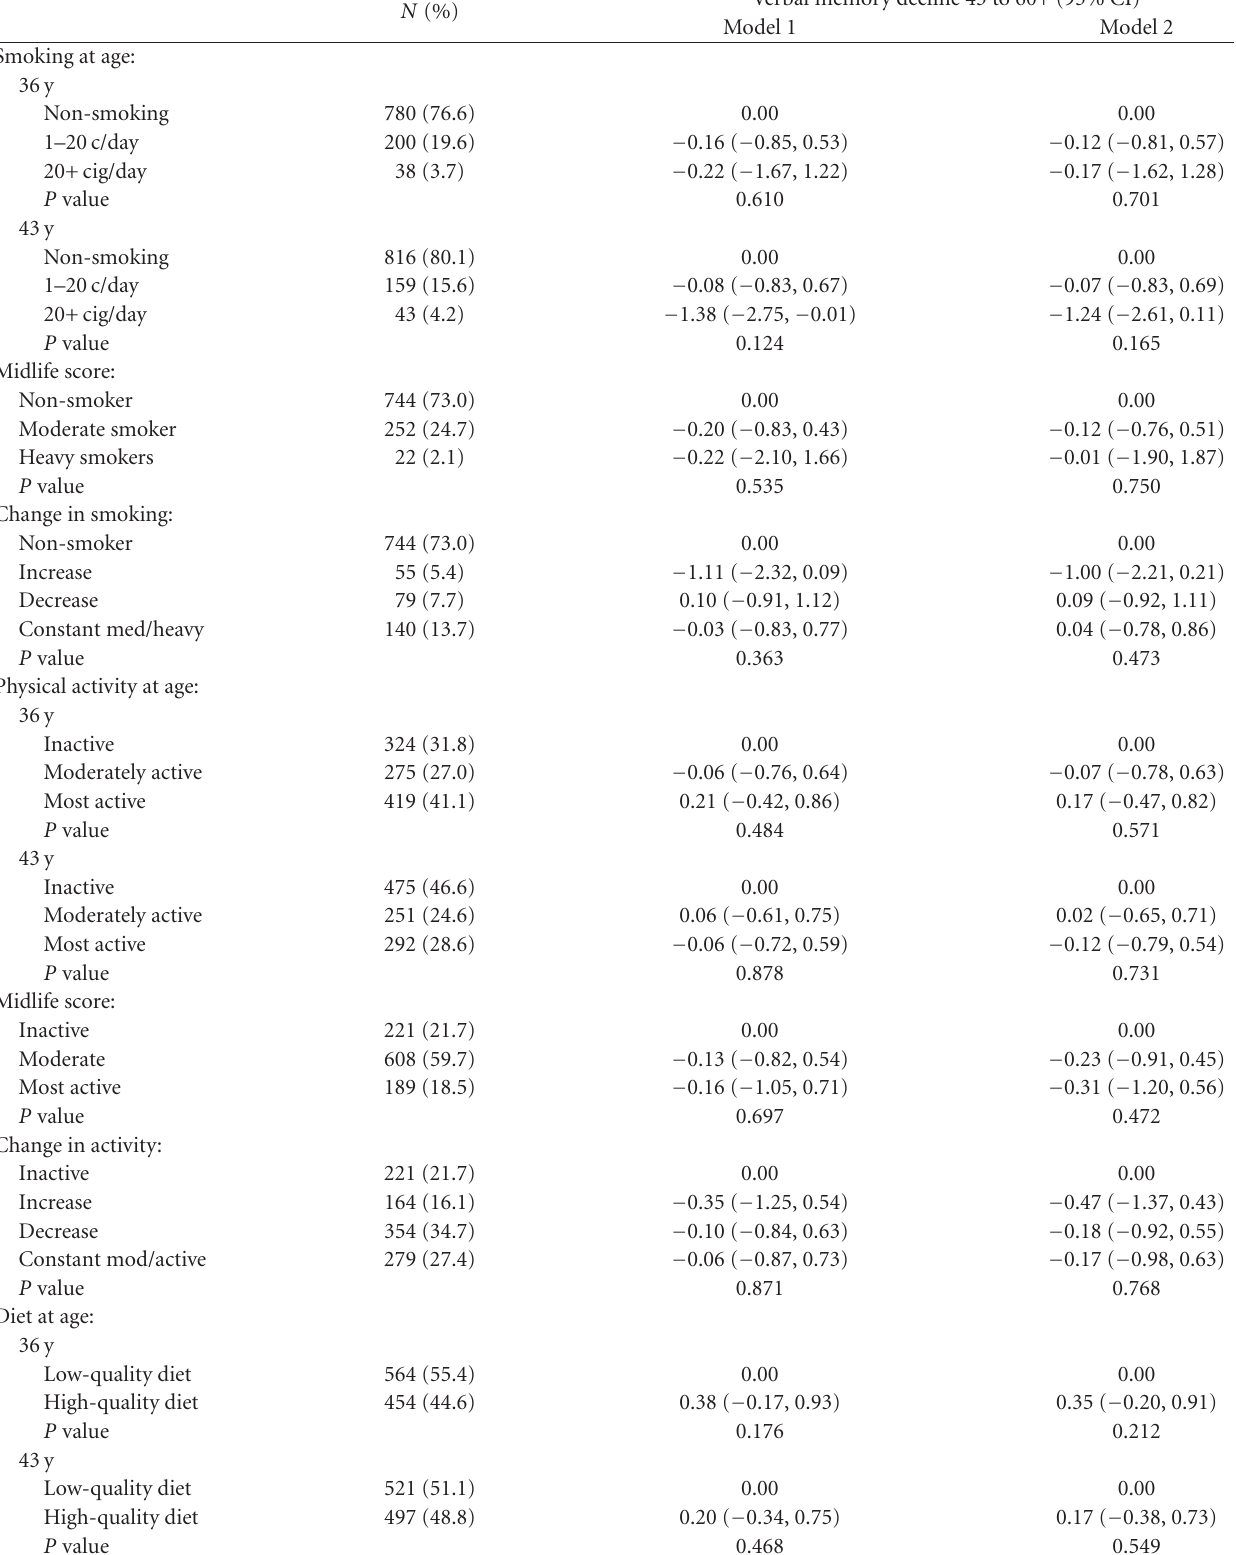
Table 2: Regression coe ffi cients (95% confidence intervals) representing rate of decline in verbal memory from 43 to 60+ years per level increase in each health behavior at 36 and 43 years and per cumulative and change in health behavior scores. N (%) Verbal memory decline 43 to 60+ (95% CI) Model 1 Model